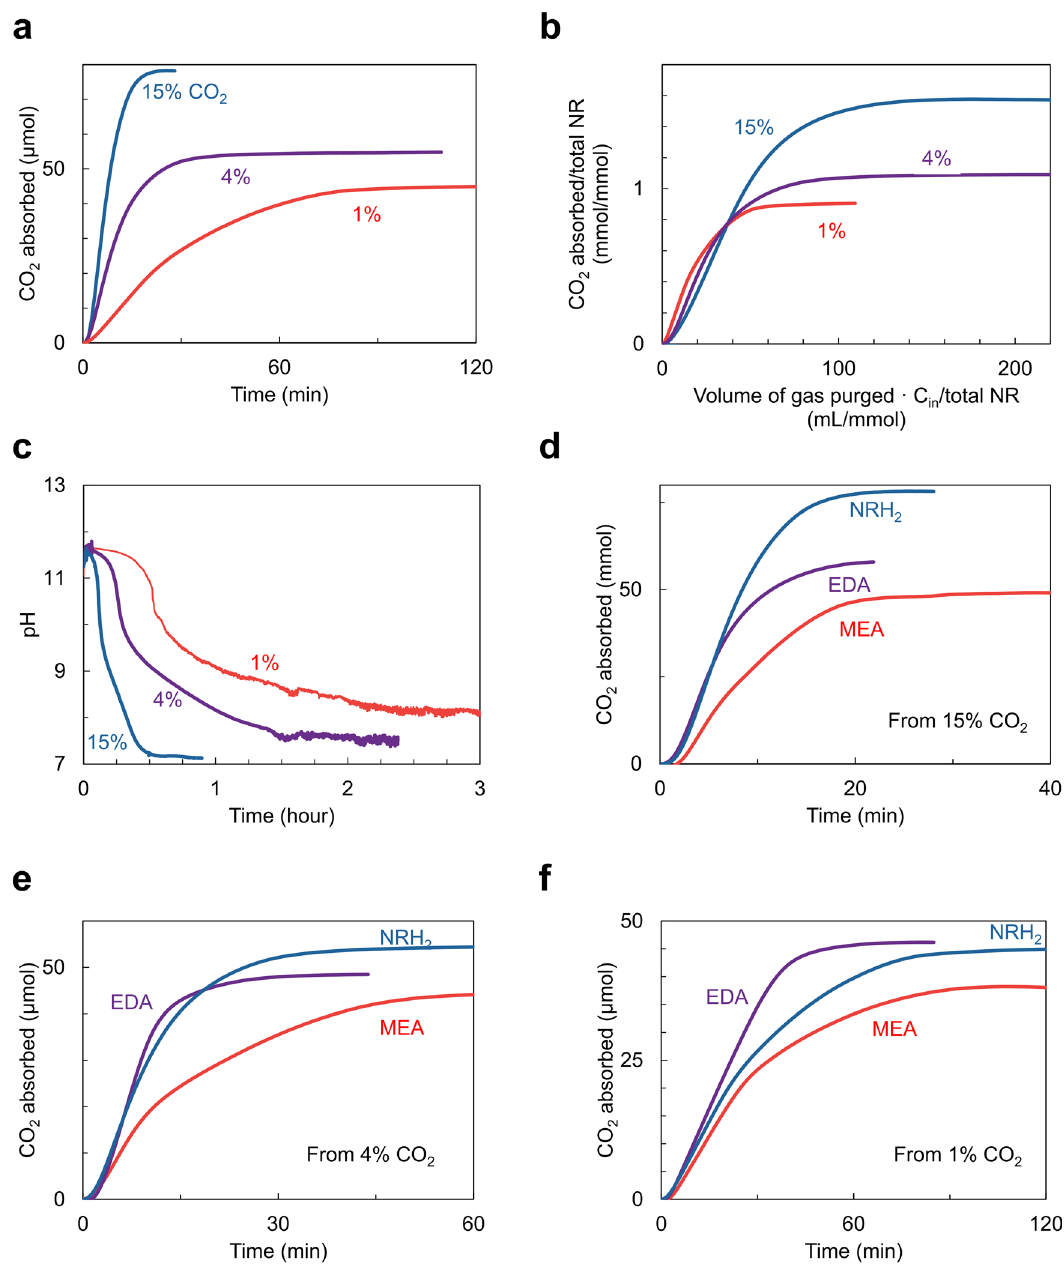
Fig.4|DynamicsofCO 2 absorptionby50mMNRH2solutions.a CO 2 absorption pro fi les at CO 2 inlet gas stream concentrations of 1 (red curve), 4 (purple curve), and15%(bluecurve).Anaqueous50mMNRH2solutionwascontactedwiththegas at a fl ow rate of 3.3mL/min at room temperature. b Normalized CO 2 absorption pro fi les. c InsitupHmeasurementduringCO 2 bubbling.PlotsofpHversustimeare displayed for 5mL of 50mM NRH2 solution with CO 2 inlet gas stream concentra- tionsof1(redcurve),4(purplecurve),and15%(bluecurve)ata fl owrateof100mL/